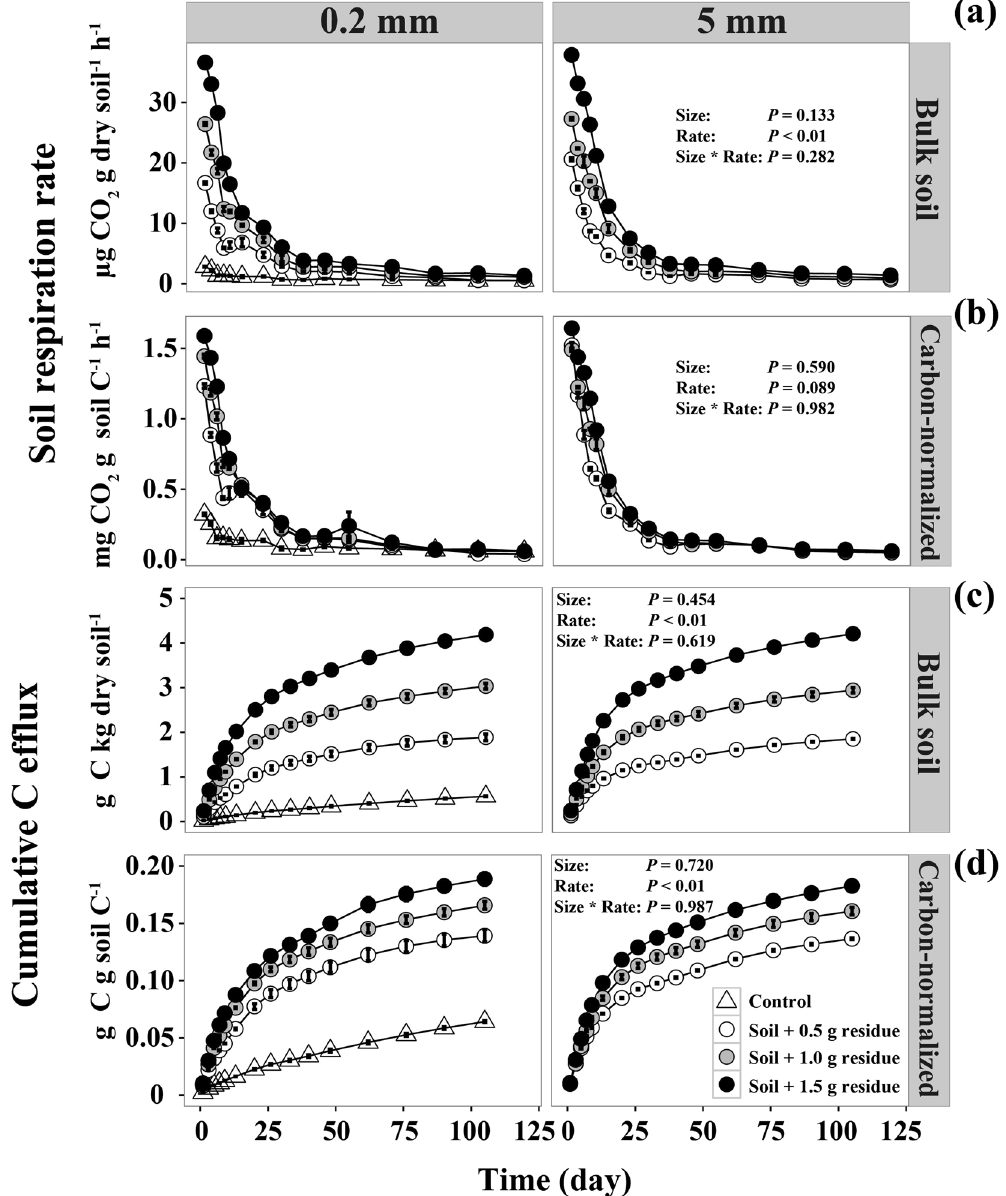
Figure 1. Effects of residue addition rate and size on microbial respiration rate ( a ), C-normalized respiration rate ( b ), cumulative C efflux ( c ) and C-normalized cumulative C efflux ( d